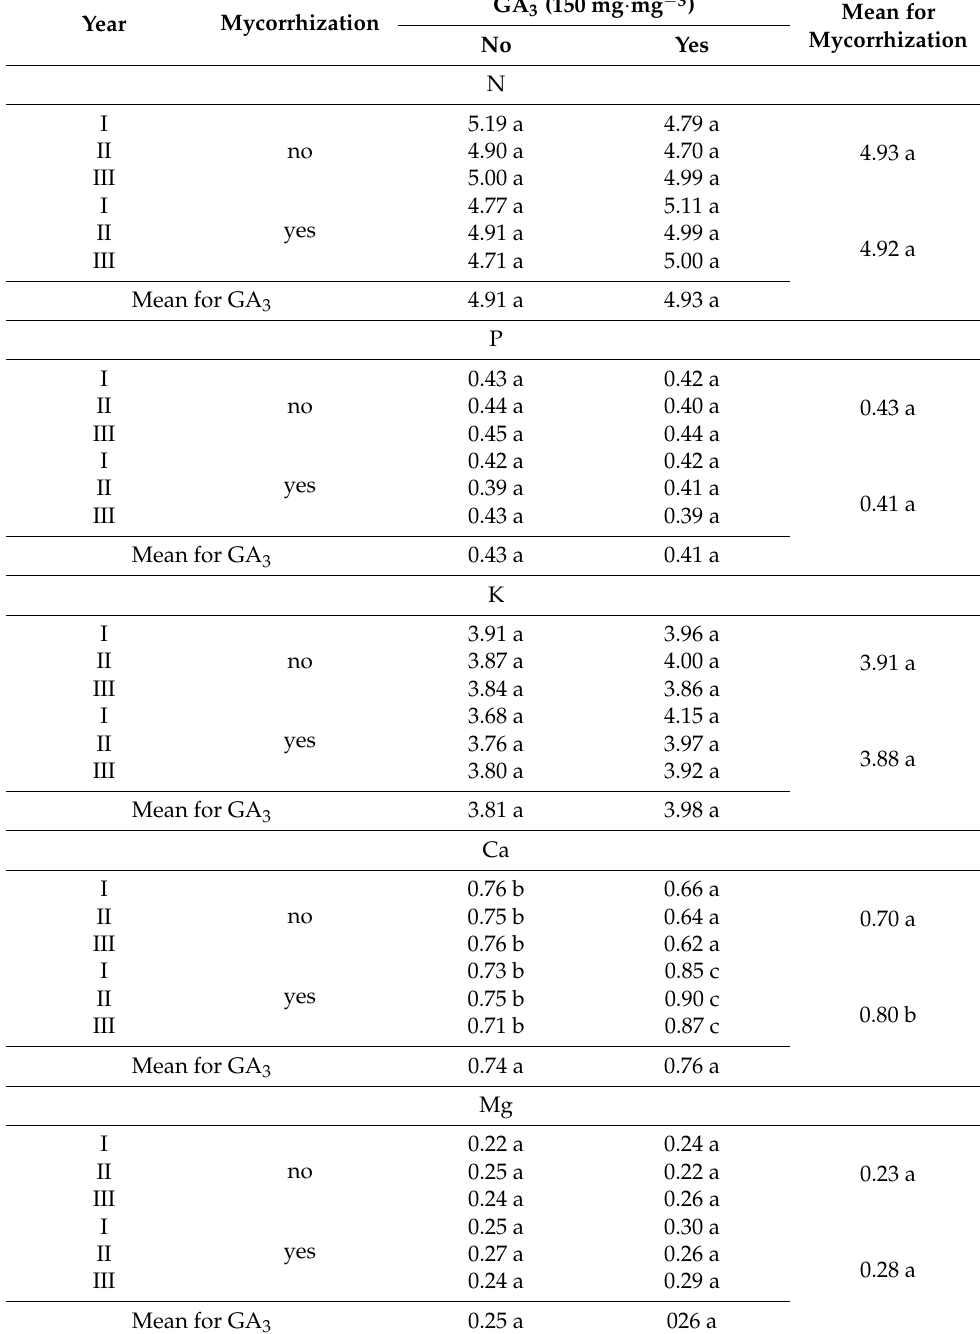
Table 2. The effect of AMF and GA 3 (% DW) on the content of macroelements in the leaves of the Zantedeschia albomaculata ‘Albomaculata’ plants. The means followed by the same letter do not differ significantly at α =